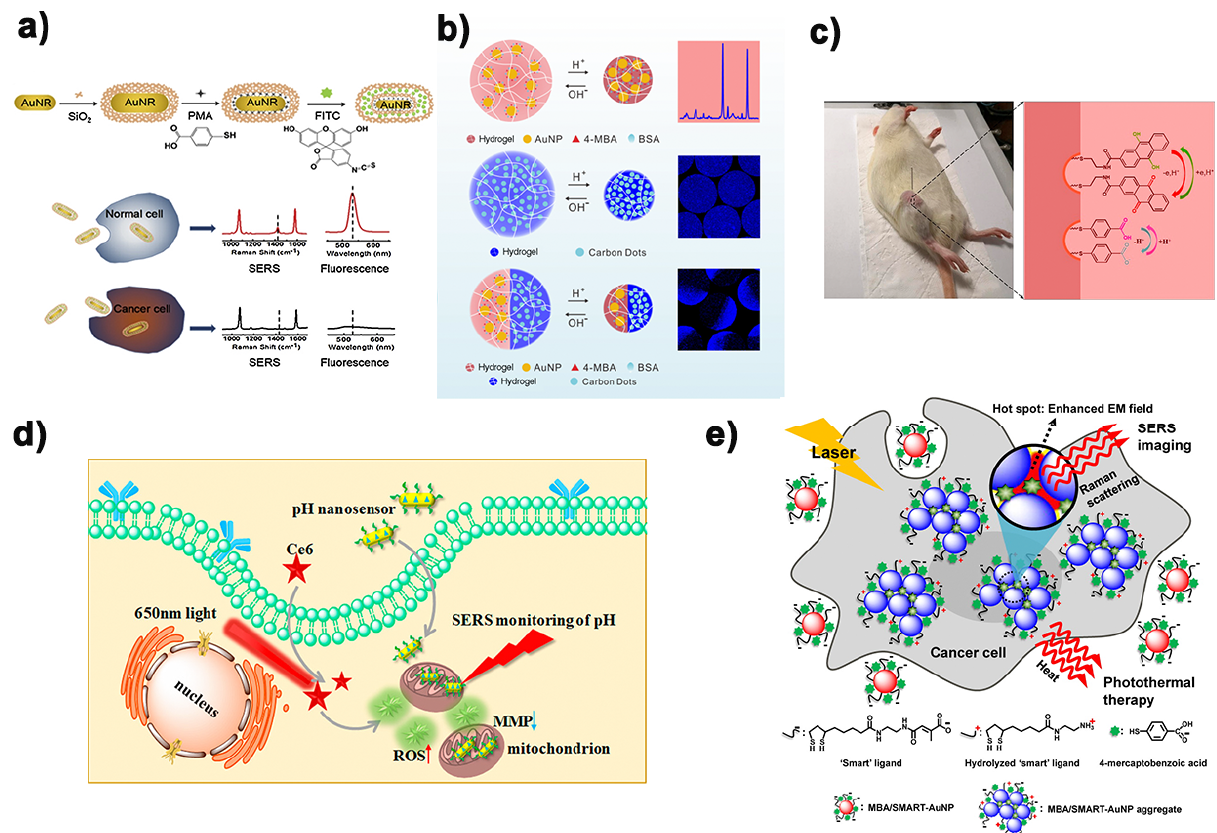
Figure 7. Some examples of pH SERS probe combined with other technologies. ( a ) SiO 2 and PMA-FITC coated AuNRs nanoprobe preparation and its mechanism in cells. Reprinted with permission from ref. [78]. Copyright 2018 Elsevier B.V. ( b ) Schematic diagram of pH-induced swell and shrinking of single-phase hydrogel microparticles encapsulating AuNPs-(4MBA)-BSA (upper), single-phase hydrogel microparticles encapsulating carbon dots (middle), and Janus hydrogel microparticles encapsulating AuNPs-(4MBA)-BSA and carbon dots, respectively, in duals semispheres (lower). Reprinted with permission from ref. [79]. Copyright 2017 American Chemical Society. ( c ) Schematic diagram of multiplexing SERS active microneedles for simultaneous measurement of redox potential and pH value. Reprinted with permission from ref. [82]. Copyright 2019 American Chemical Society. ( d ) Procedure of the selective determinations of microenvironmental changes in mitochondria during PDT progress. Reprinted with permission from ref. [80]. Copyright 2020 American Chemical Society. ( e ) Schematic diagram of the working mechanism of 4-MBA-functionalized smart nanoparticles in cancer cells. Reprinted with permission from ref. [83]. Copyright 2013 American Chemical Society.